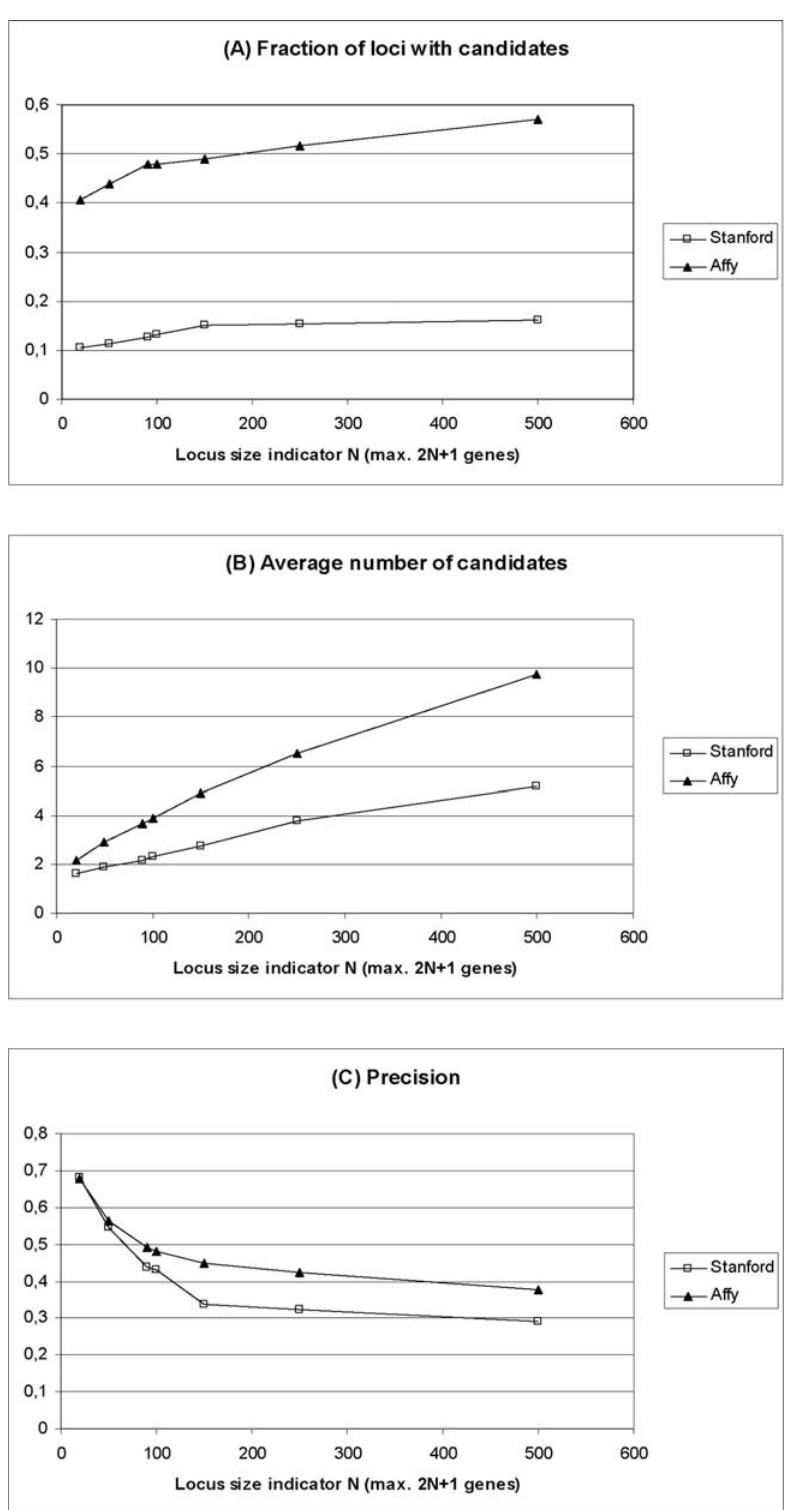
Figure 3. Performance of the identification of candidate disease genes as determined by a leave-one-out strategy. Artificial loci of different sizes were constructed around known disease genes as explained in the text. (A) Fraction of the artificial loci for which it was possible to identify at least one candidate gene, as a function of the locus size. (B) Average number of candidates in the loci for which at least one candidate was identified, as a function of the locus size. (C) Precision as a function of the locus size. Precision is determined as the ratio between the number of loci whose candidate list contained the starting disease gene and the number of loci with candidates. Filled triangles indicate the results obtained with the Affy network, while empty boxes refer to the Stanford network.